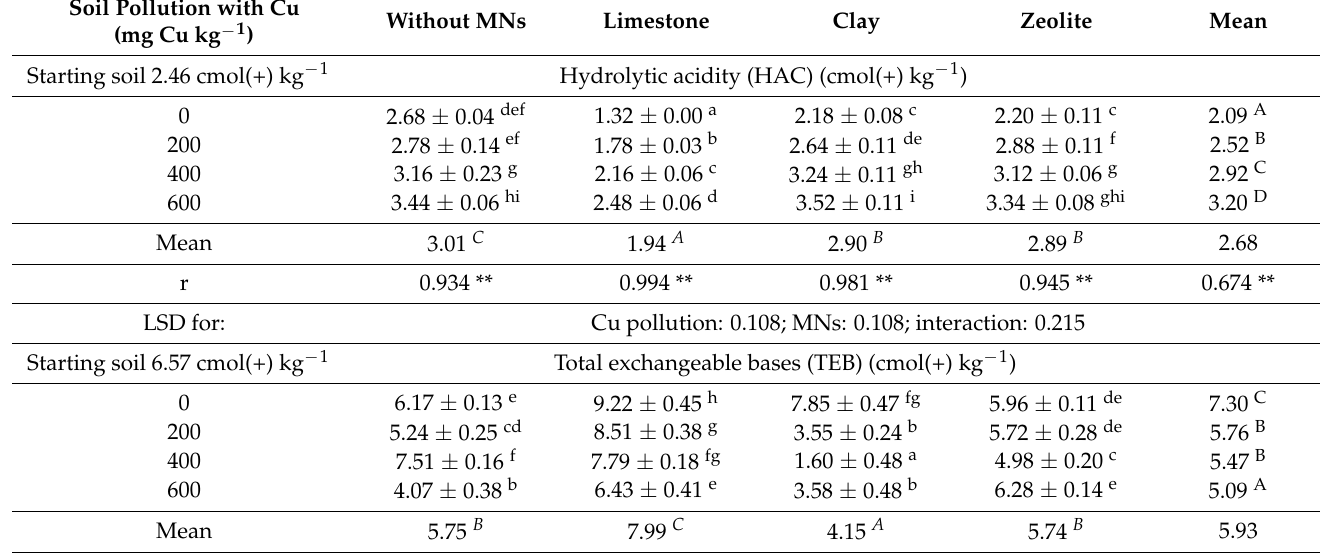
Table 2. Selected physicochemical properties of the soil after black mustard ( Brassica nigra L. Koch) harvest.